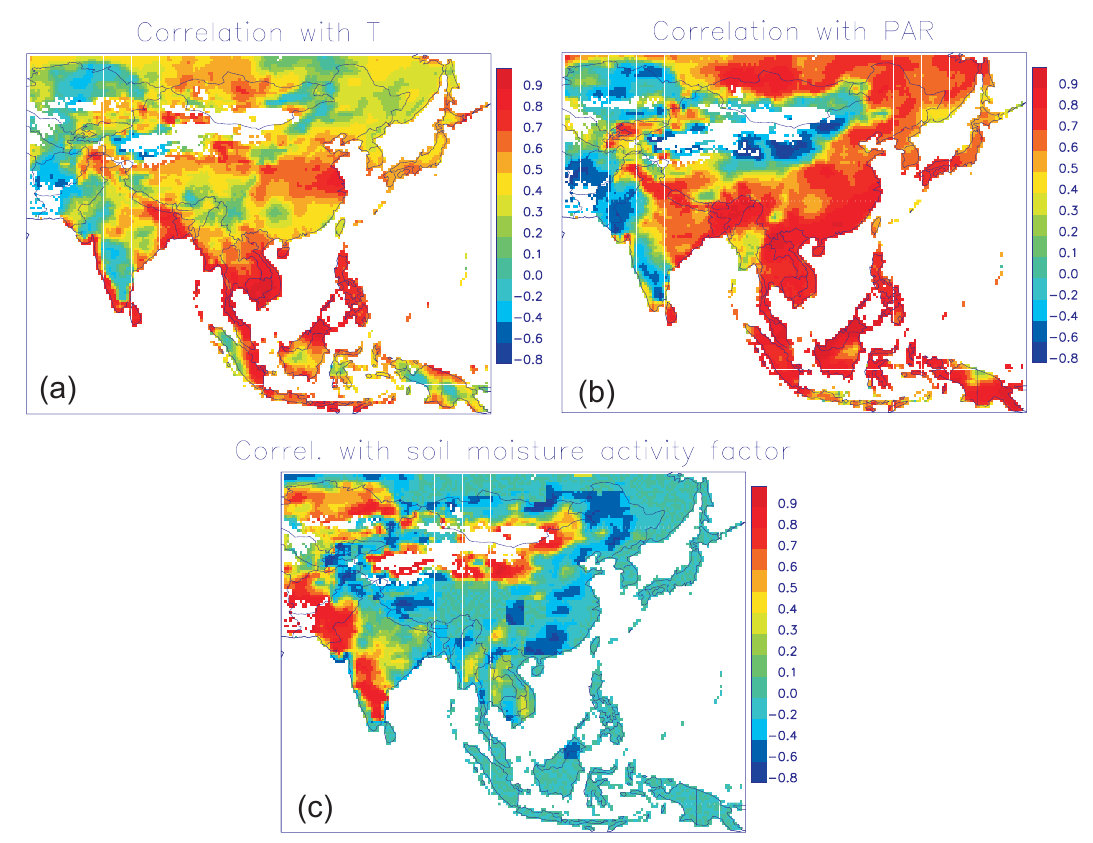
Fig. 4. Correlation coefficient between the annual isoprene emission and air temperature (a) , above-canopy solar radiation (b) , and the soil moisture stress activity factor (c) over